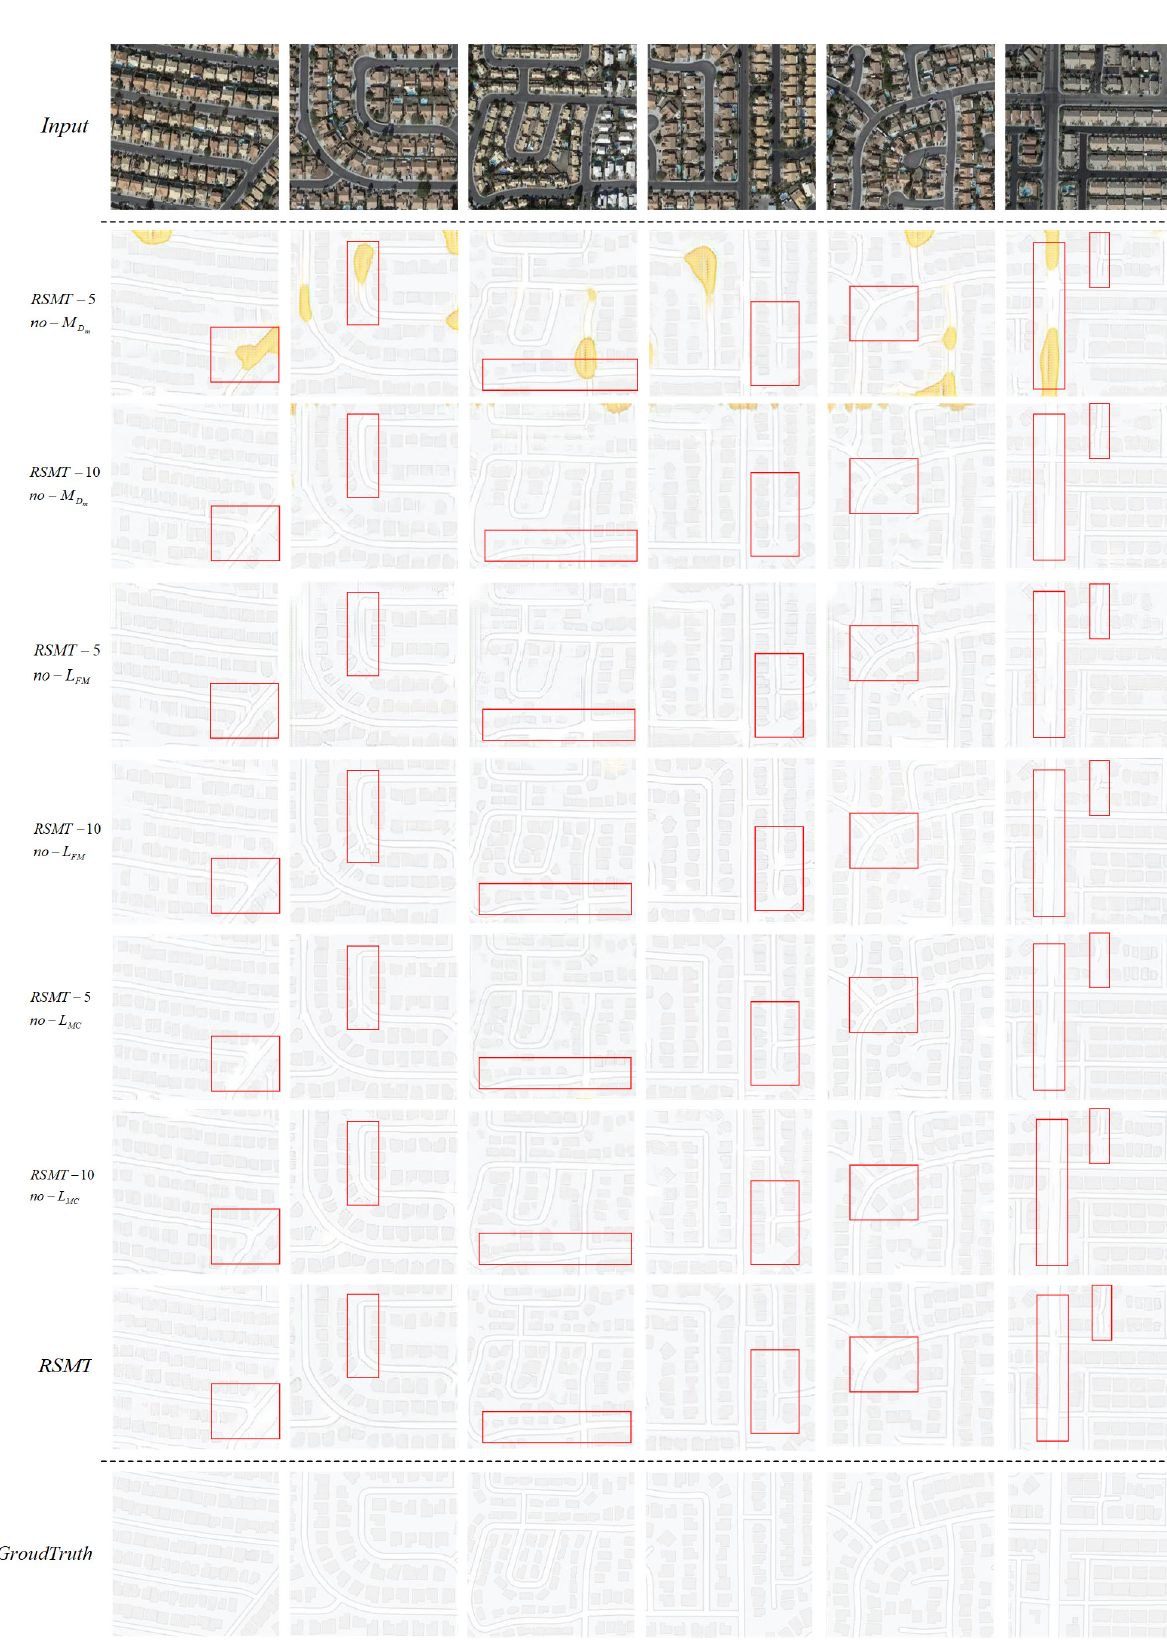
Figure 7. Qualitative comparisons over removing the core elements from the remote sensing image- to-map translation model RSMT. From top to bottom, the lines are input remote sensing images, translation results of RSMT-no- M D , RSMT-no- L FM , RSMT-no- L MC by setting K = 5 and K = 10, m translation results of RSMT, and ground